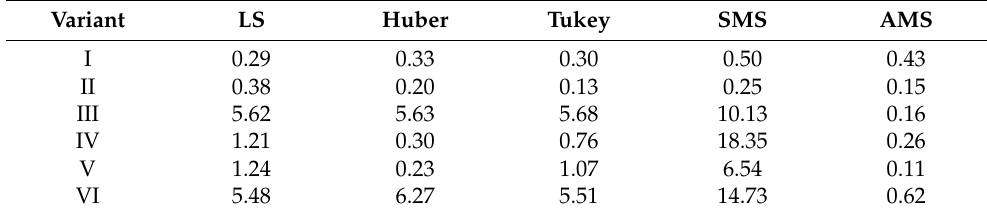
Table 1. RMSDs of estimated displacements (mm).